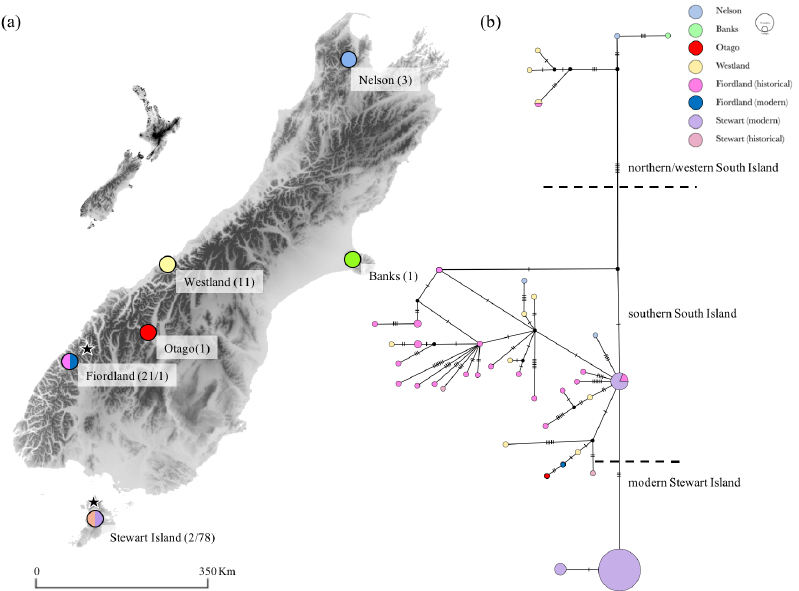
Figure 3. ( a ) Sampling locations for 39 historical and 79 modern k¯ak¯ap¯o. Full circles represent sampling locations for historical specimens only and split circles refer to sampling locations for both historical specimens and modern birds. Numbers represent sample sizes for each location and dataset. Stars represent geographic origin of the founders. ( b ) Median-joining haplotype network for 118 k¯ak¯ap¯o mitogenomes (16,588 bp). Geographical locations in the legend are listed from north to